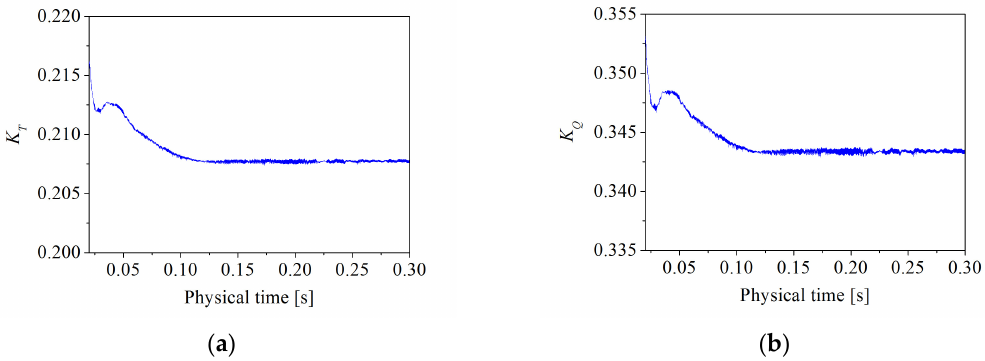
Figure 4. Thrust and torque coefficients as a function of physical time at advance coefficient J = 0.7: ( a ) thrust coefficient K T and ( b ) torque coefficient K Q .